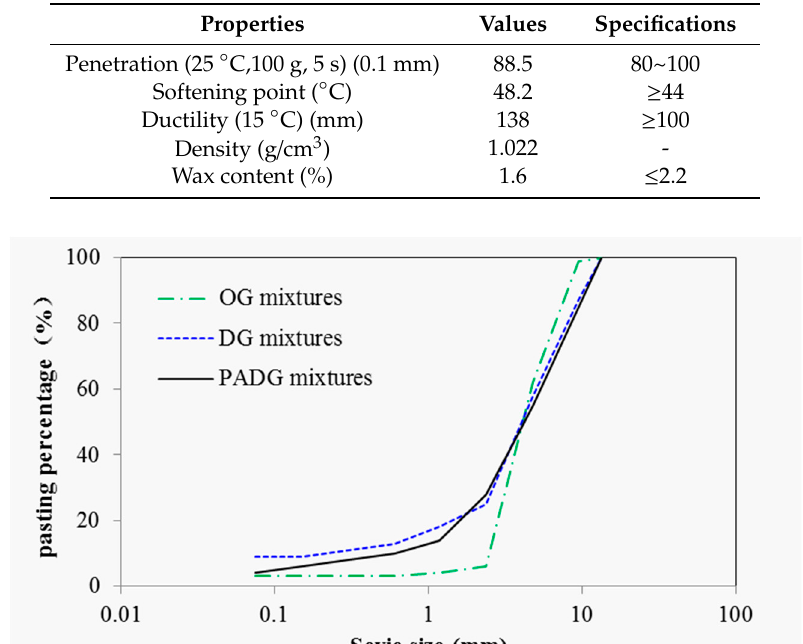
Figure 4. Microscopy images of microcapsules in additive. Table 1. The main properties of 90# matrix asphalt.